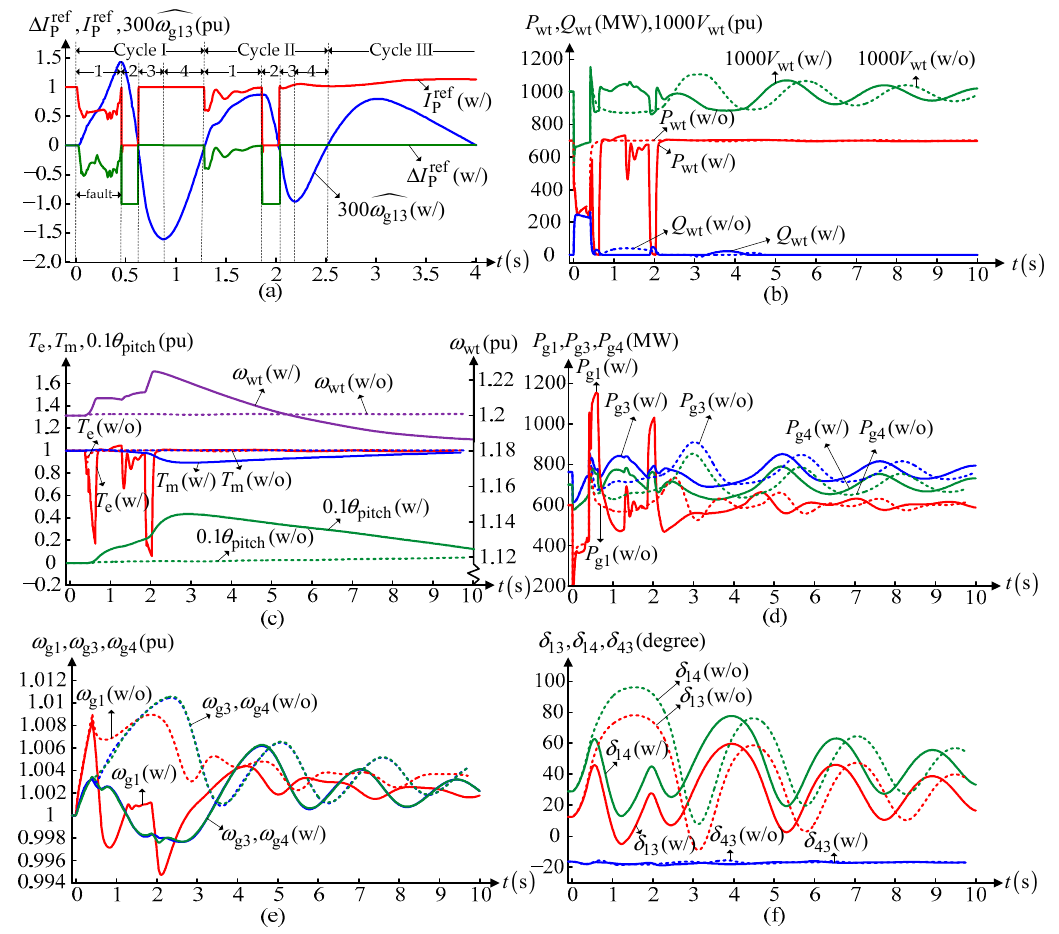
Figure 9. Time-domain dynamics of some variables within the case pair corresponding to 125% length